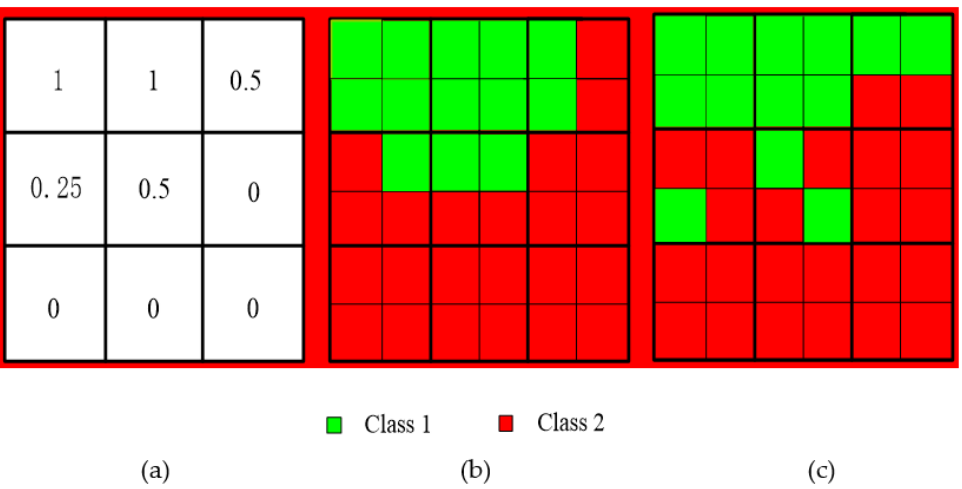
Figure 1. Schematic diagram of spatial correlation: ( a ) the soft classification result of Class 1; ( b ) the probability of distribution 1; ( c ) the probability of distribution Class 2.